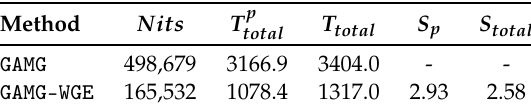
Figure 13. The iteration numbers of the linear equations in 2D NACA0012 airfoil. Table 3. The test result of 2D NACA0012 airfoil †